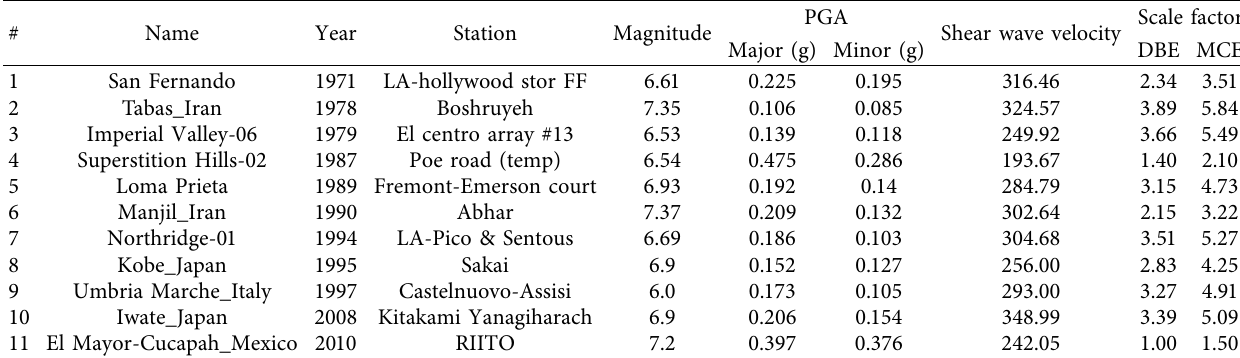
Table 6: Description of ground motion